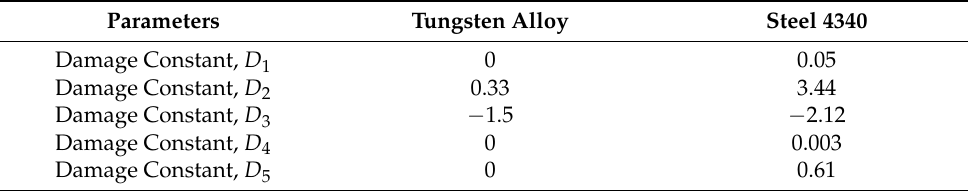
Table 3. JC failure model constants for the tungsten alloy and steel 4340 [30].